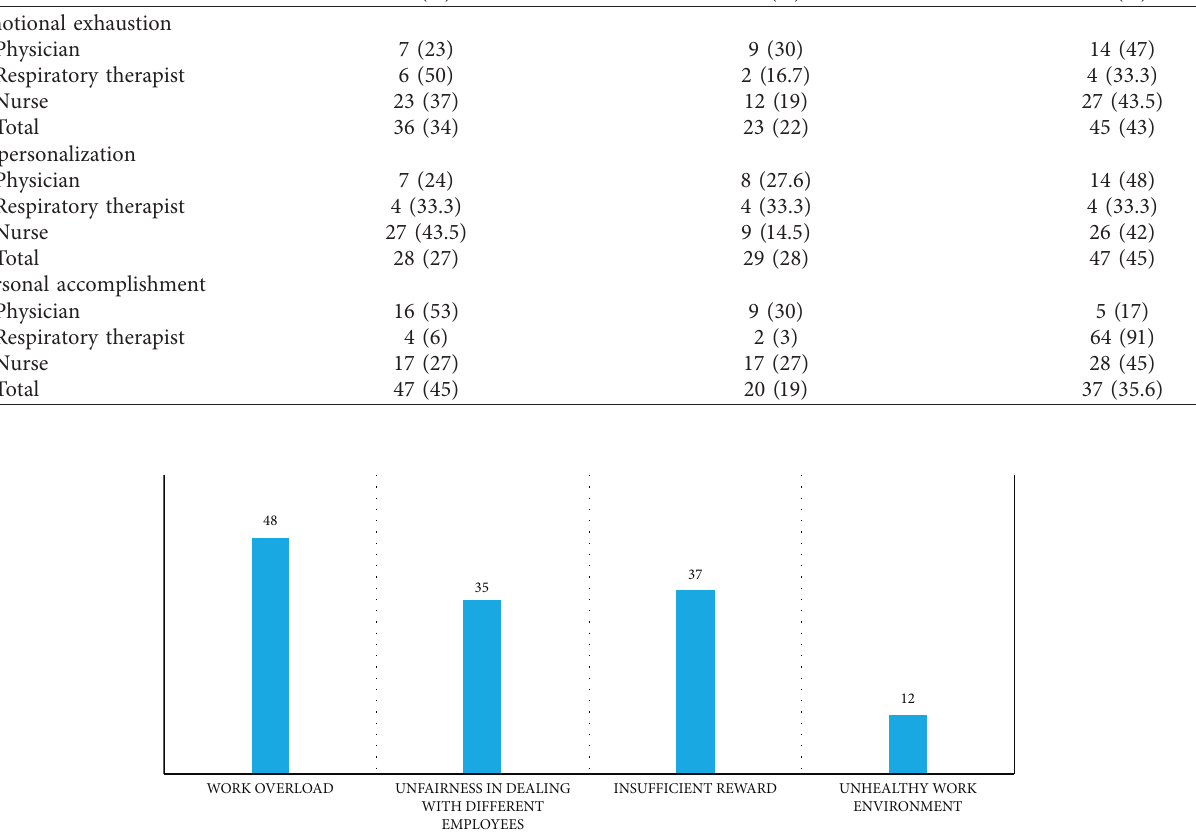
Figure 1: Factors identified by ICU staff that cause occupational burnout.